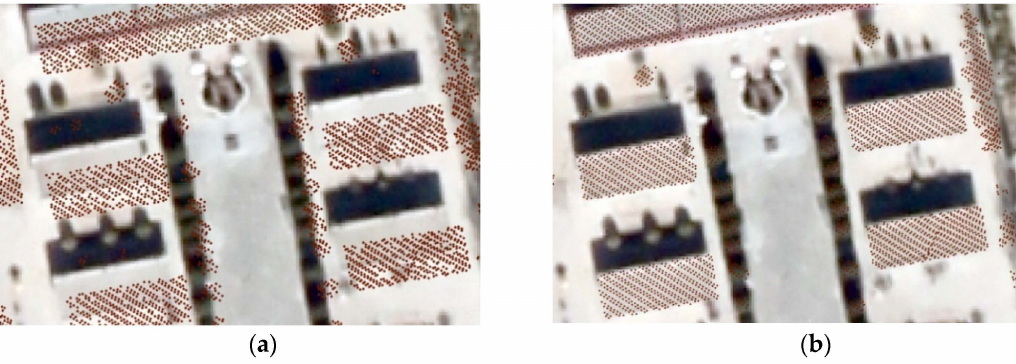
Figure 7. Comparison of before and after registration. ( a ) Before registration; and ( b ) after